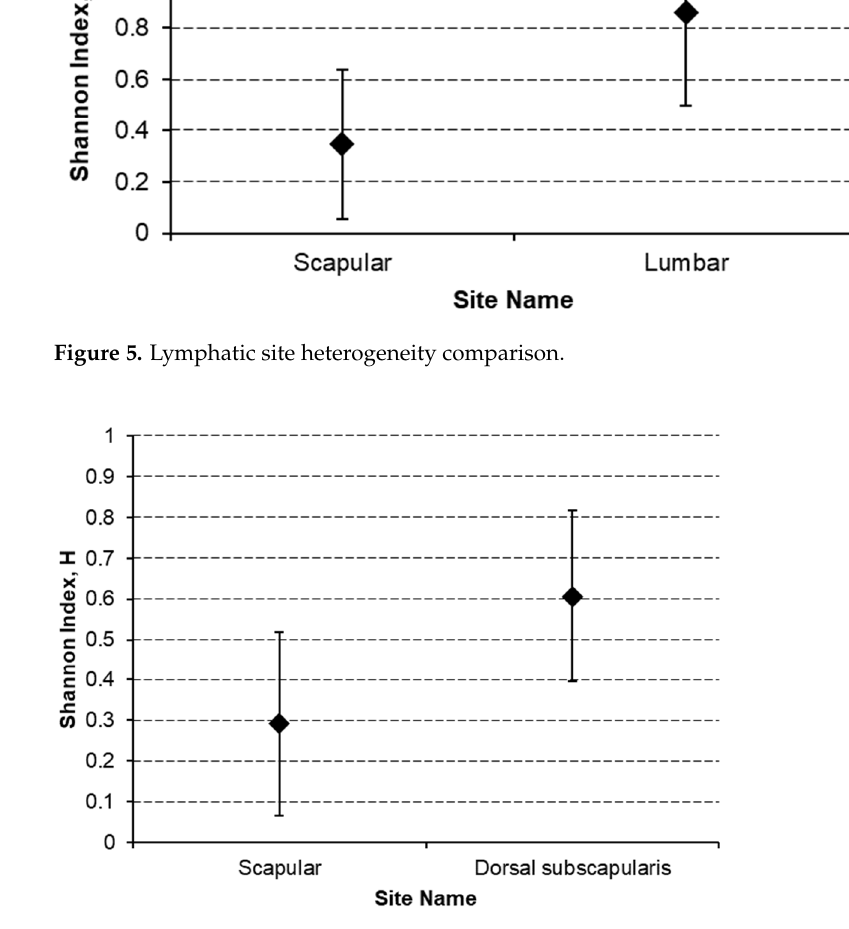
Figure 6. Lymphatic laterality heterogeneity comparison.